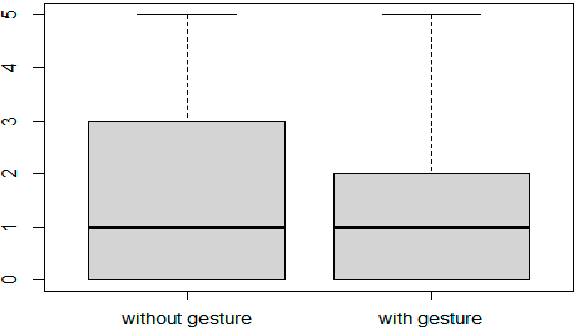
Figure 5. Box plot for testing results in the Expressive Post-Test 1 condition.